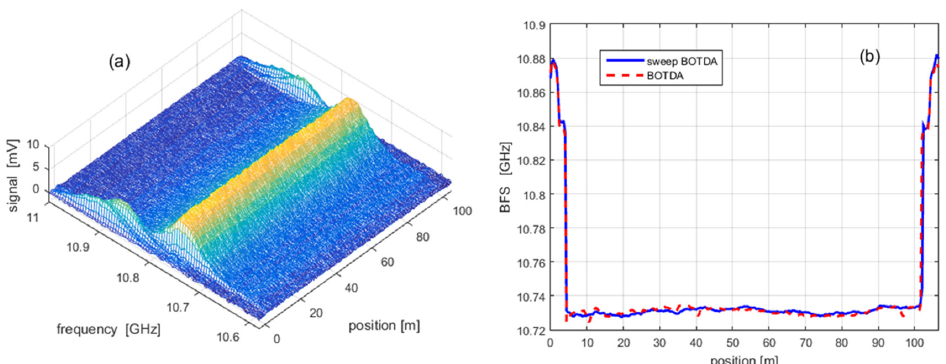
Figure 21. (a) BGS acquired by using a linearly swept probe frequency, in a sweep time of 33 ms; ( b ) Comparison of the BFS profile acquired using either the FAST BOTDA method with a linearly swept frequency, or the conventional BOTDA method.